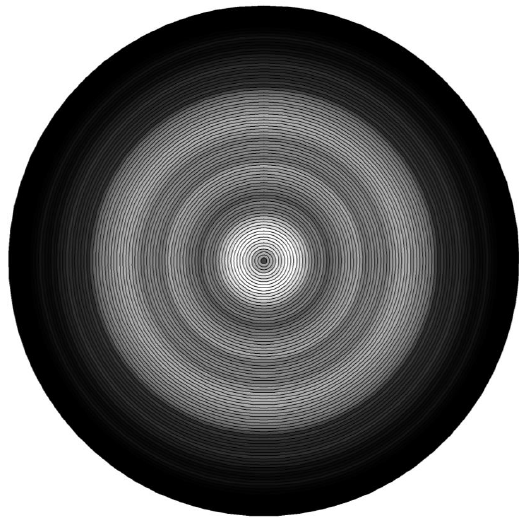
Figure 6. The 1°-ringed hemispherical sky-oriented photo with a gray scale range of values associated with the canopy closure values. Dark colored rings indicate a high level of canopy closure and white rings indicate less forest media.